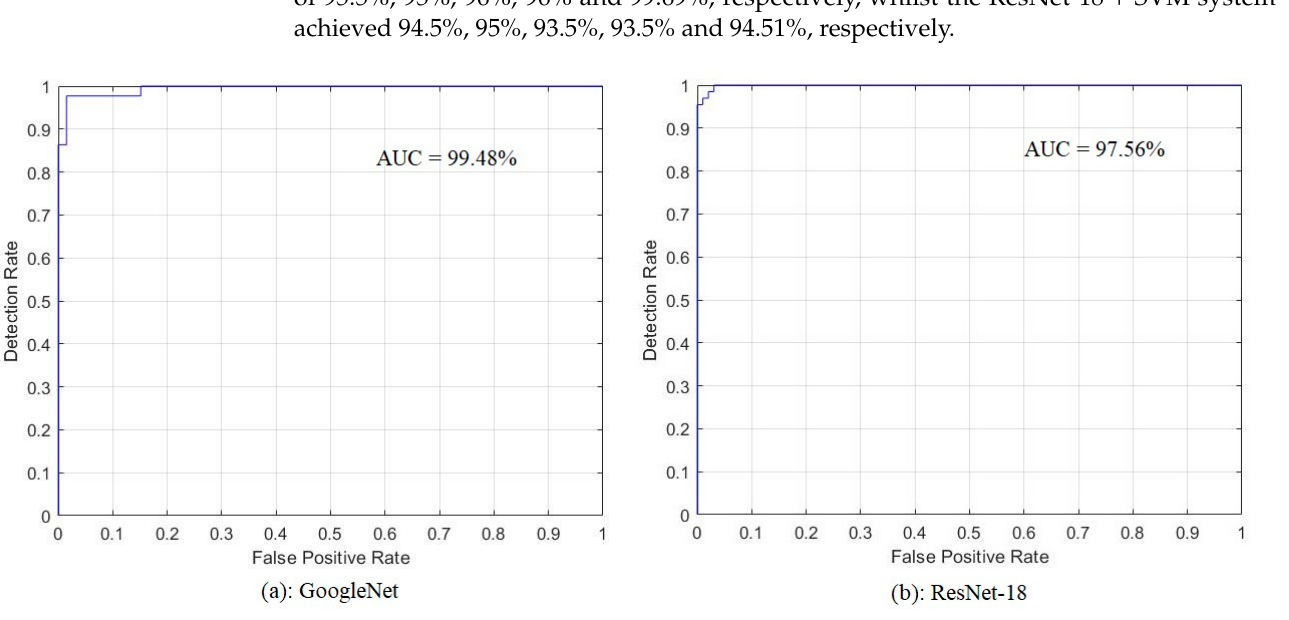
Figure 18. Area under the curve (AUC) of ASD dataset. ( a ) GoogleNet and ( b ) ResNet-18. Table 8. Performance of GoogleNet + SVM and ResNet-18 + SVM systems on ASD dataset.